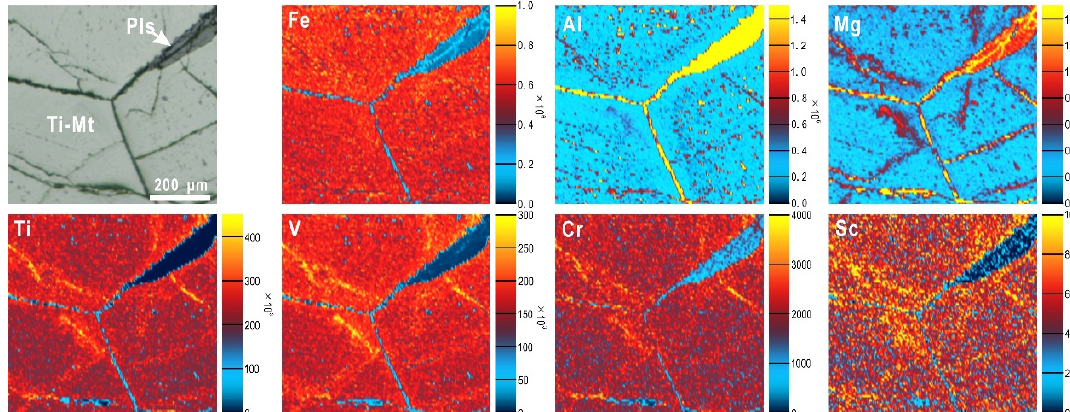
Figure 3. Reflected light photomicrograph (top left) and LA-ICP-MS maps showing patterns of trace elements distribution at the triple junction between three titanomagnetite (Ti-Mt) grains. The grain boundaries host pleonaste (Pls). The maps show internal substructures concentrating Mg, Ti, V, Cr, and Sc. Scales in counts-per-second. Extended maps are shown in Supplementary Materials Figure S3.